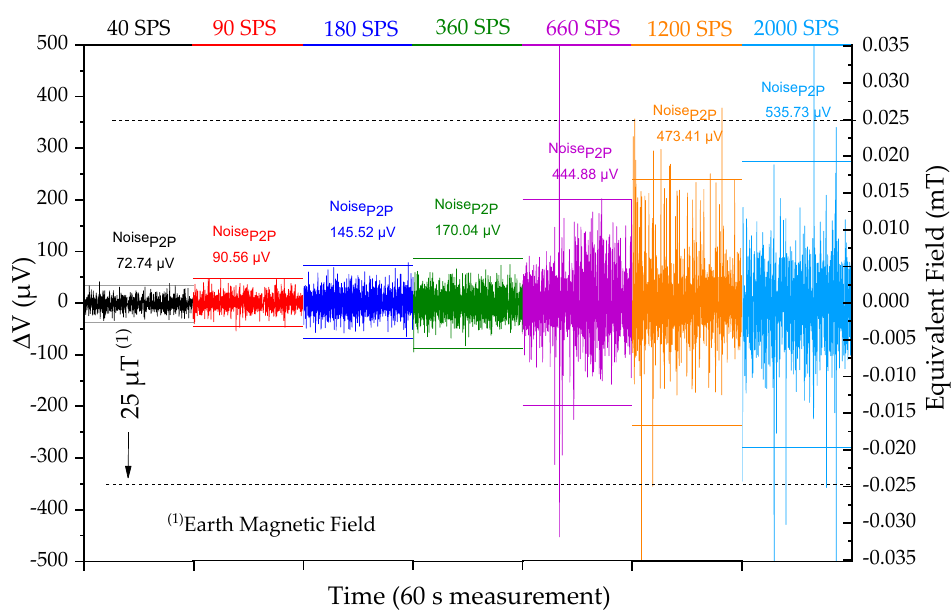
Sensors 2021 , 21 , x FOR PEER REVIEW 10 of 25